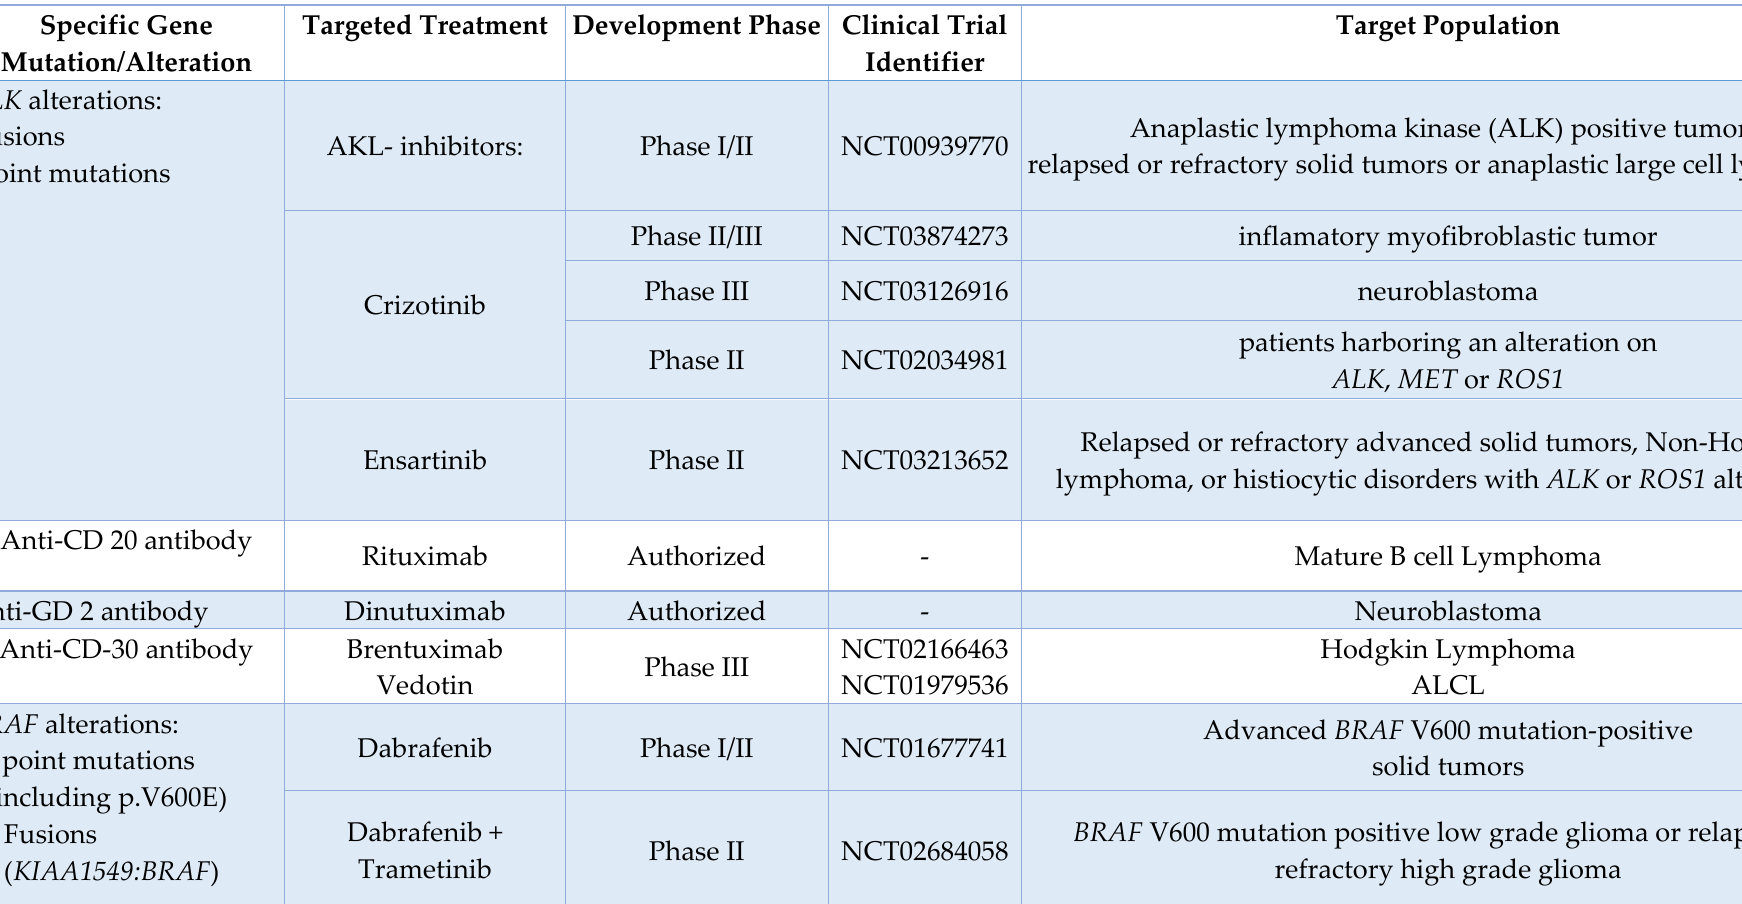
Table 10. Selected targeted treatments for pediatric solid tumours—authorized or under development.